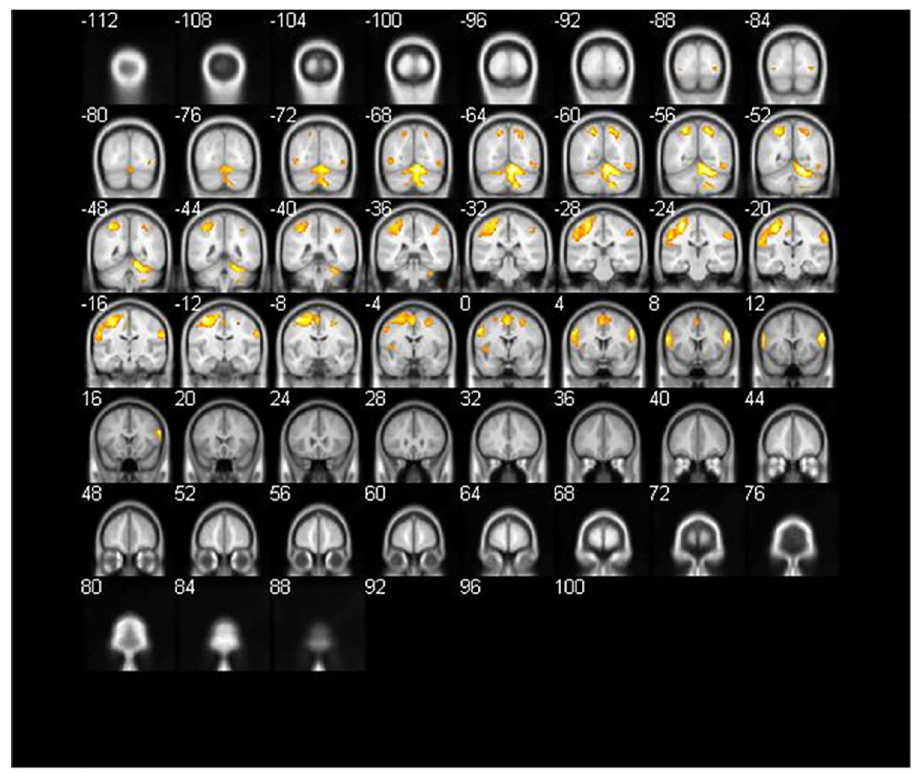
Fig 7. Brain activation for refinement (B2) versus preliminary ideas (B1) (coronal